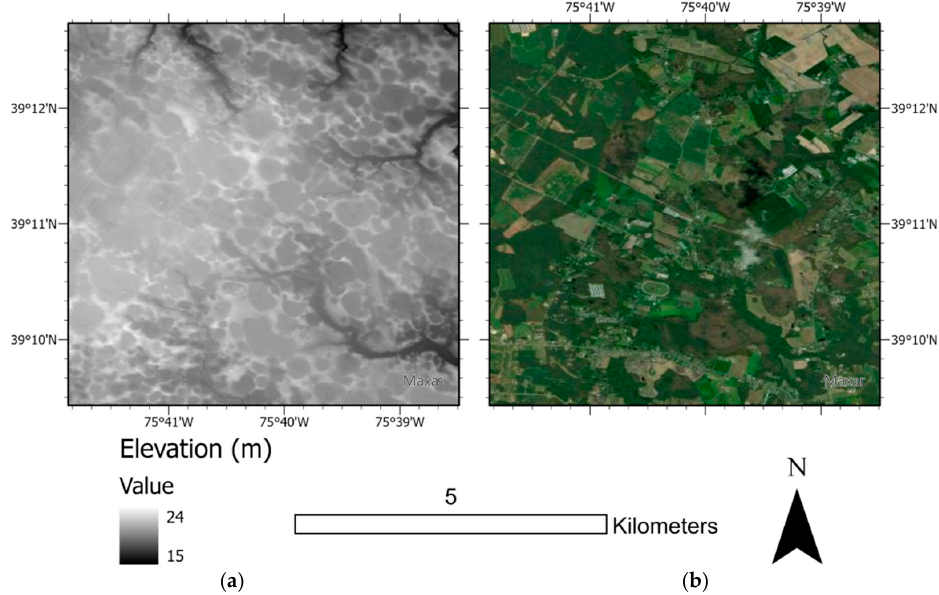
Figure 2. Carolina Bays in central Delaware. ( a ) LiDAR DEM gridded at 10 m. ( b ) Aerial imagery from ESRI World Imagery basemap.